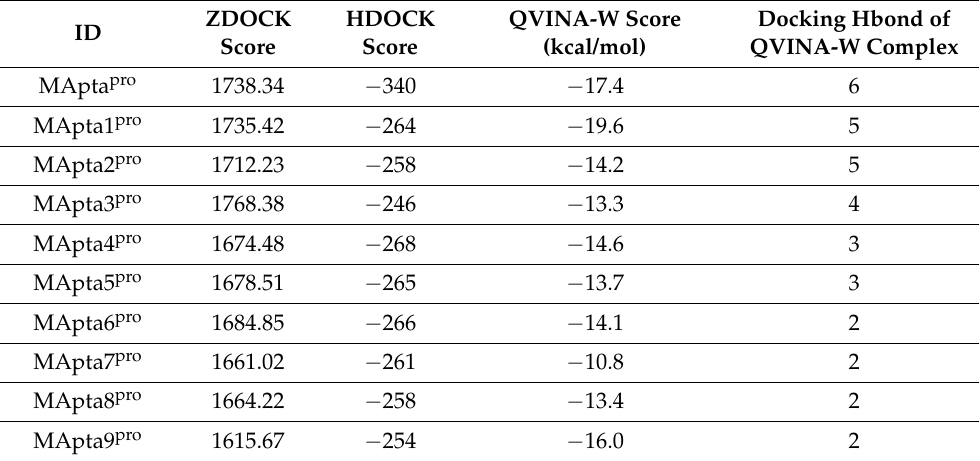
Table 1. Docking score of the best 10 de novo ssRNA aptamer against M pro structures.